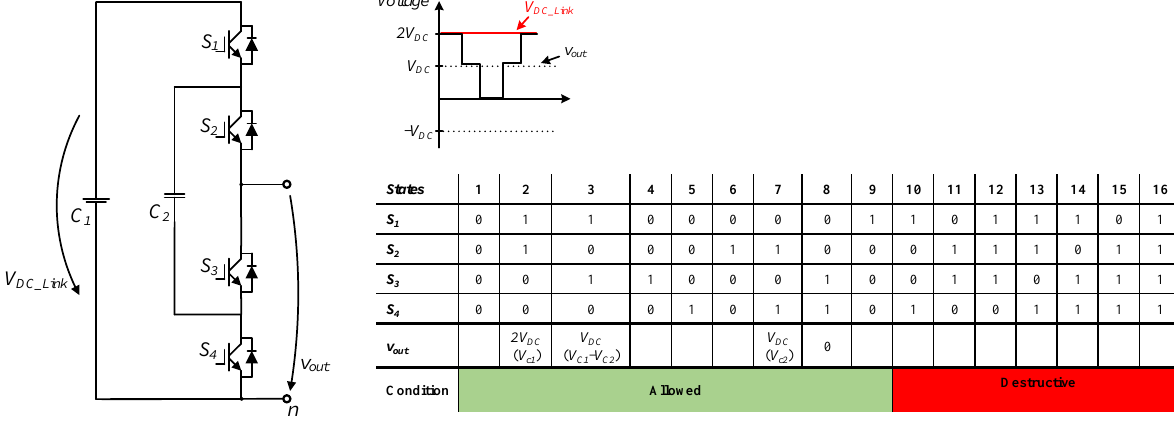
Figure 10. Conventional submodule NPC topology for cascaded applications and operation princi- ple.